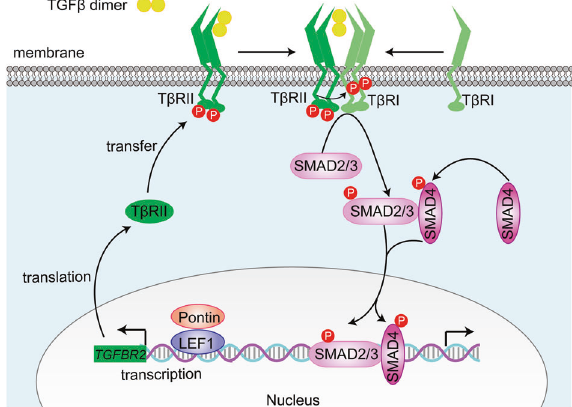
Fig. 9 Schematic illustration of the mechanism by which Pontin promotes gliomagenesis through ampli fi ng TGFBR2 transcription and activating TGF β /SMAD